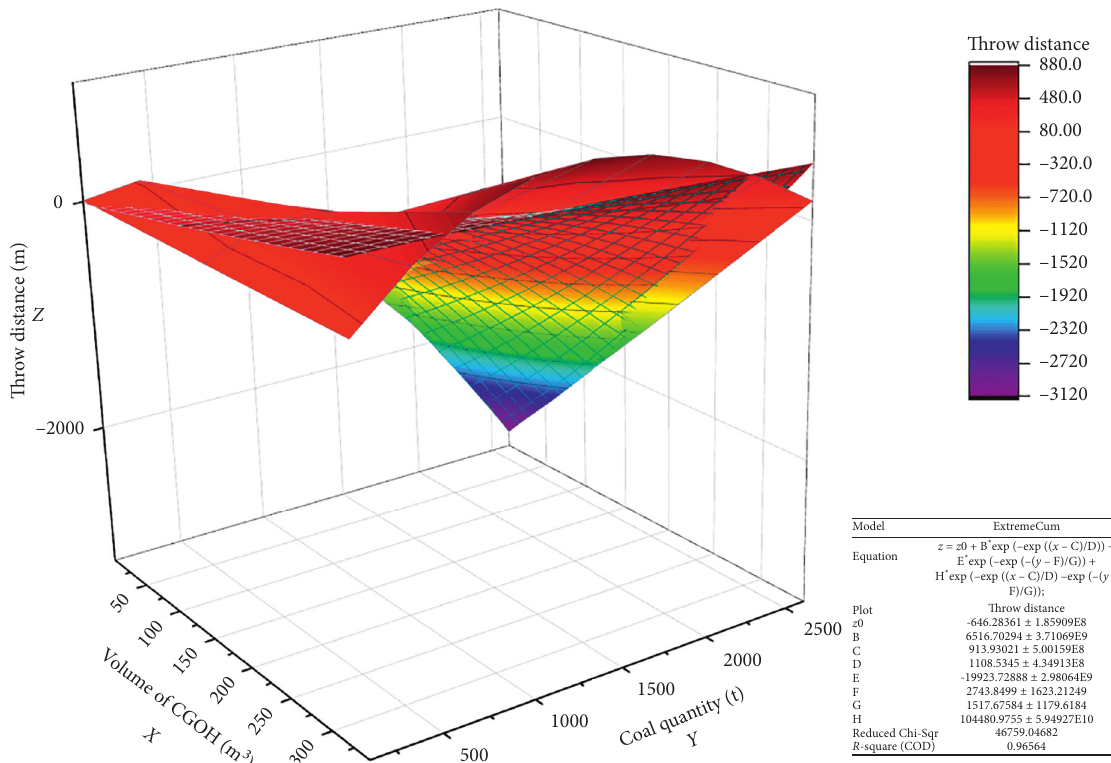
Figure 23: 3D colormap surface of CGOH parameters and its nonlinear surface fit (Extreme Cum).